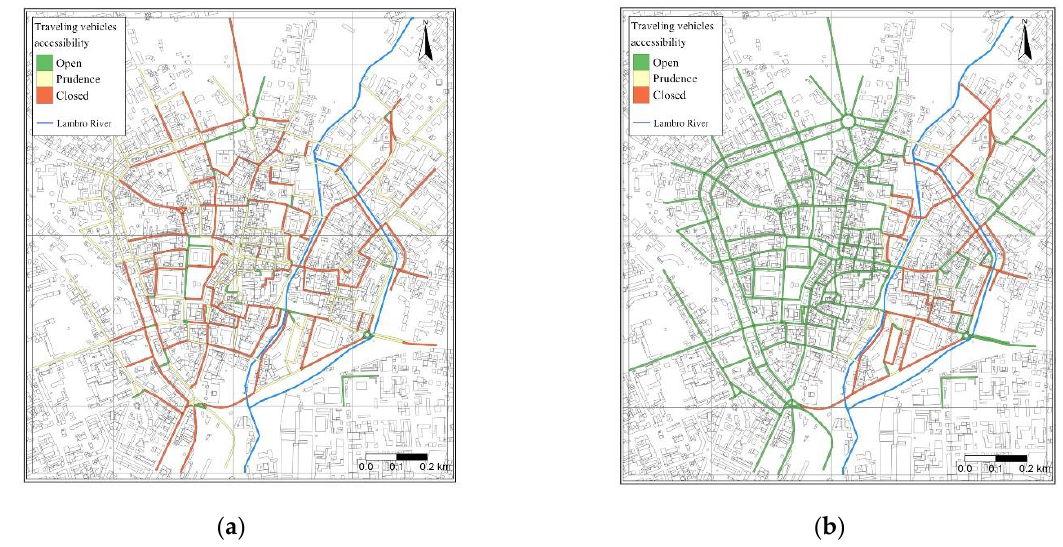
Figure 3. Maps of road accessibility at T = 100 y: ( a ) pluvial and ( b ) river hazard.